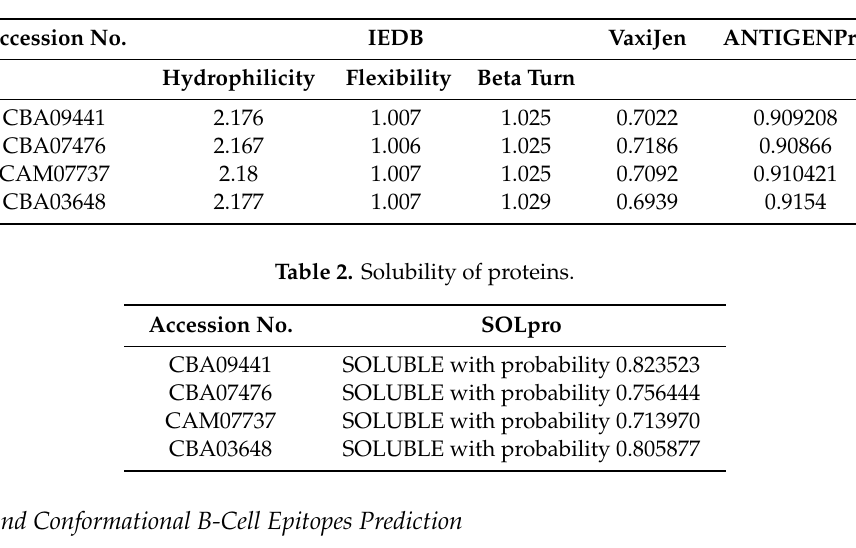
Table 1. Antigenic and immunogenic properties of proteins.